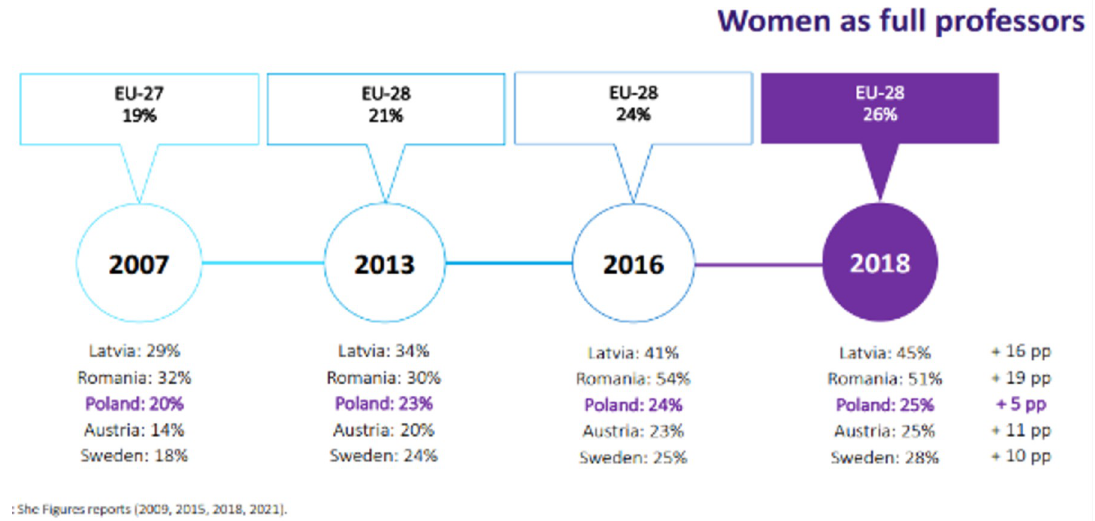
Fig 3. Percentage of female professors in selected EU countries (2007, 2013, 2016, 2018). Source: She Figures 2009, 2015, 2018, 2021, after: A. Knapi ń ska, Women in science in Poland. Changing rules of the game, Webinar: "Gender equality in European Research, Innovation and Higher Education. How to enhance scientific excellence through Gender Equality Plans?",